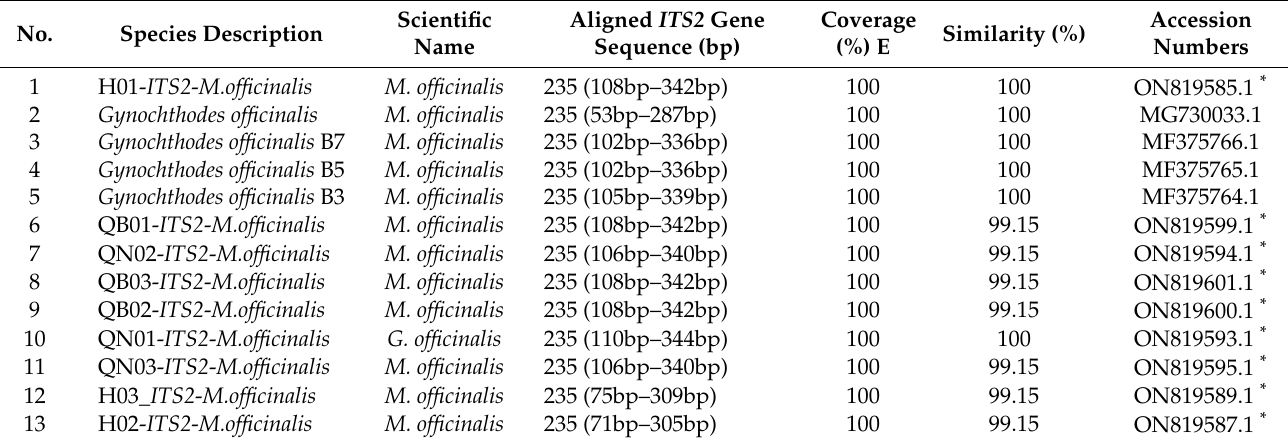
Table 4. M. officinalis plants in this study and the percentage of similarity to the closest species in the GenBank as per ITS2 gene sequences.